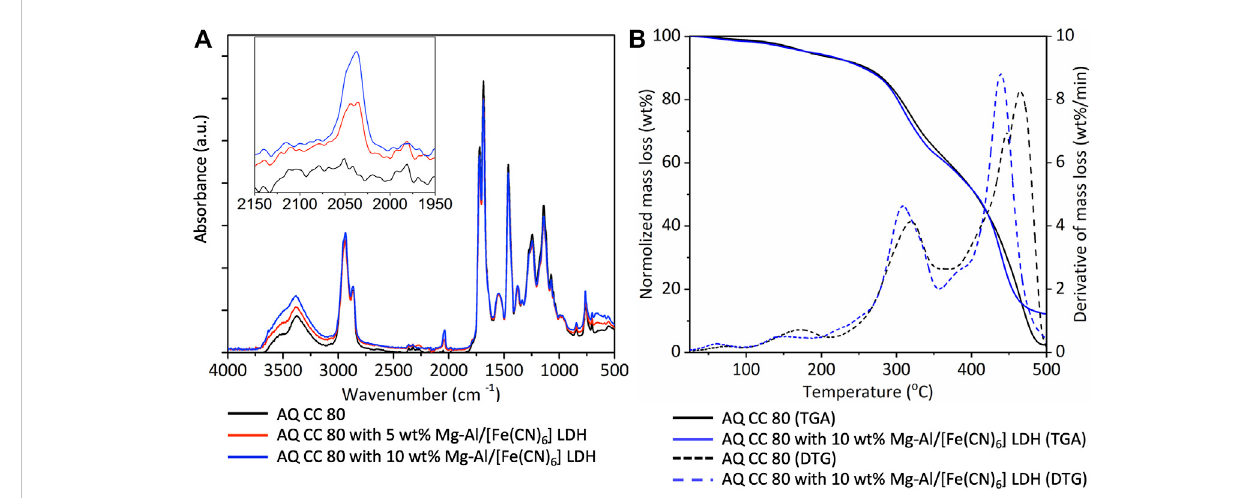
FIGURE 8 Structural characterization of acrylic polyurethane AQ CC 80 coating with and without Mg-Al/[Fe(CN) 6 ] LDH nanoadditive via FTIR (A) , thermal characterization of acrylic polyurethane AQ CC 80 coating with and without Mg-Al/[Fe(CN) 6 ] LDH nanoadditive via TGA and DTG (B)